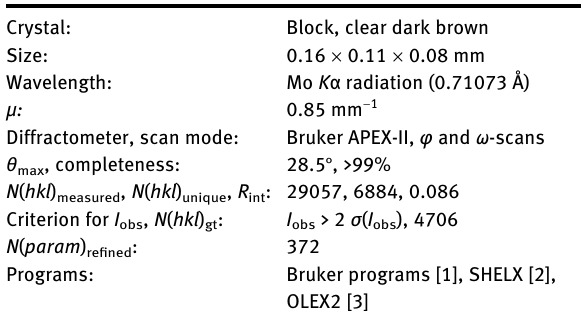
Table  : Data collection and